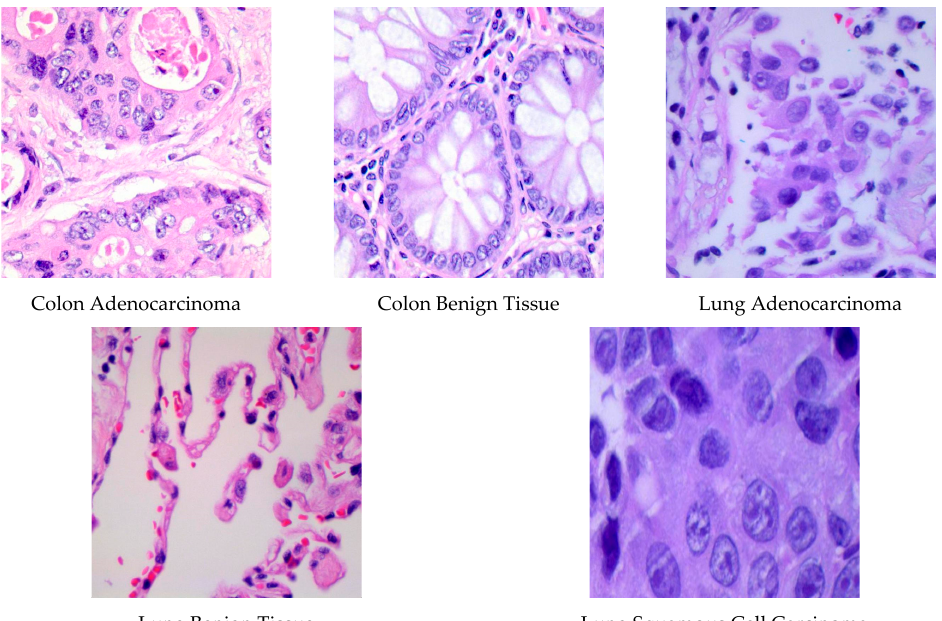
Figure 1. Lung and colon image samples of the dataset.